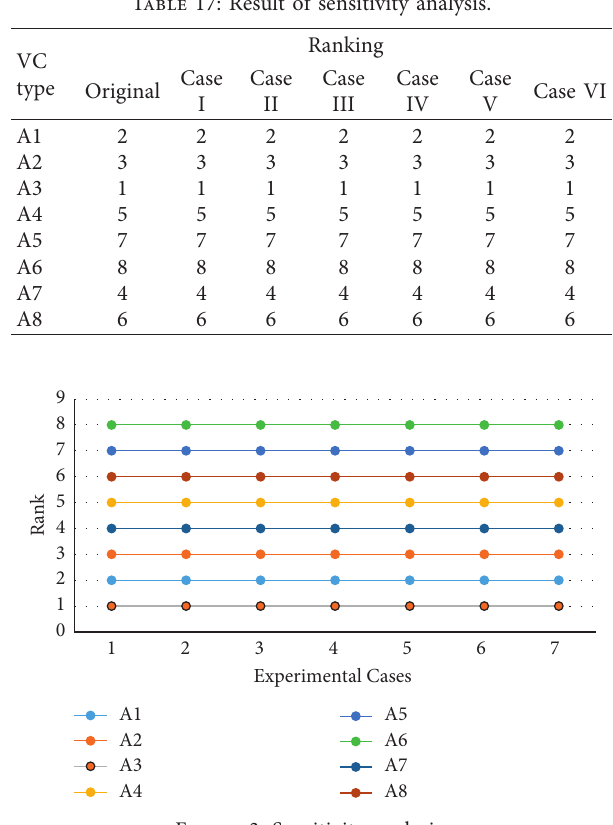
Figure 3: Sensitivity